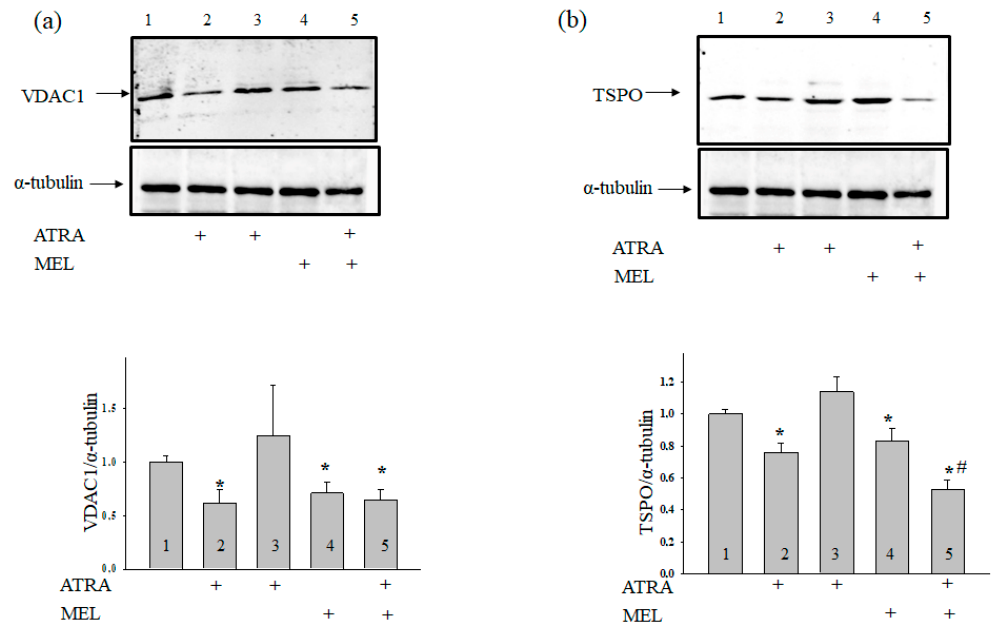
Figure 4. Combined effect of MEL and ATRA on the level of TSPO and VDAC1 in HL-60 cells. Cells were seeded in a 96-well plate at a density of 5 × 10 3 cells per well and treated with 1 µ M ATRA (column 2), and 10 nM ATRA (columns 3) and 1 mM MEL (column 4), and MEL in combination with 10 nM ATRA (column 5); untreated cells (control, column 1). Immunodetection of α -tubulin was used as a loading control. ( a ) Immunostaining (upper part) and quantitation (lower part) of the protein level of VDAC1; ( b )-of TSPO. Bar graphs represent the levels of appropriate proteins in relative units. The protein level in a cell lysate without any addition was taken to be unity and served as a control. The data are presented as means ± S.D. of five separate experiments. * p < 0.05 significant difference in protein level in comparison with corresponding control, # p < 0.05 significant difference in the protein level compared to the value obtained in the presence of MEL alone.